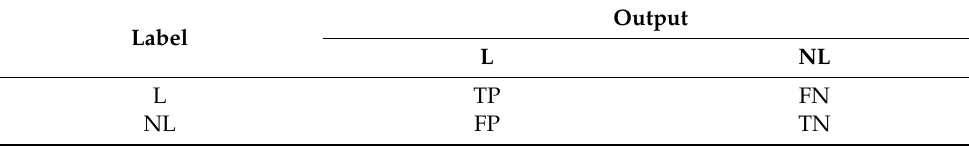
Table 1. Confusion